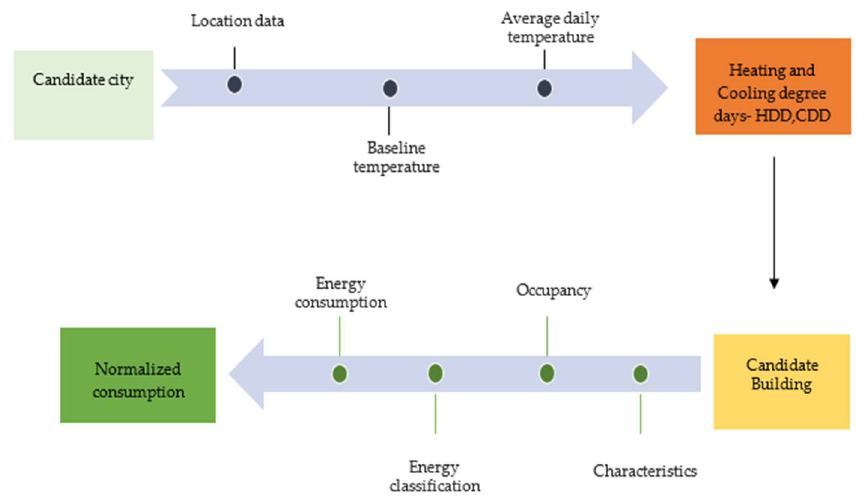
Figure 4. Energy related KPI-normalization process .